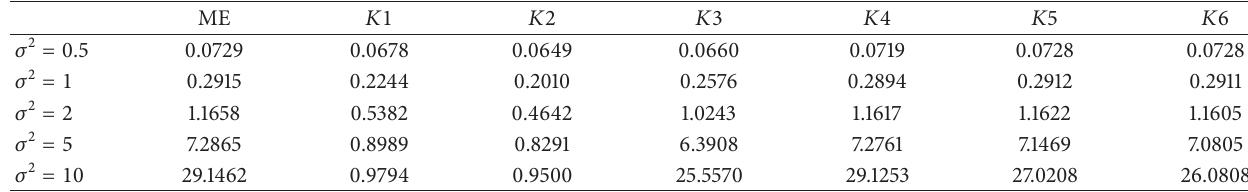
Table 18: Estimated MSE with 𝑛 = 50 , 𝑝 = 8 , and 𝛾 = 0.85 .